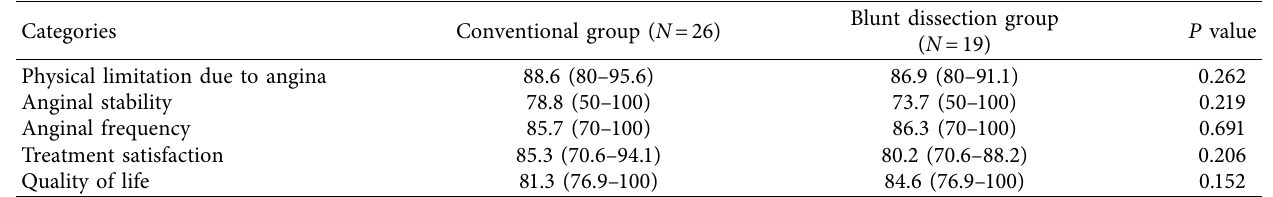
Table 6: Seattle Angina Questionnaire Scores after unroofng operation in the two